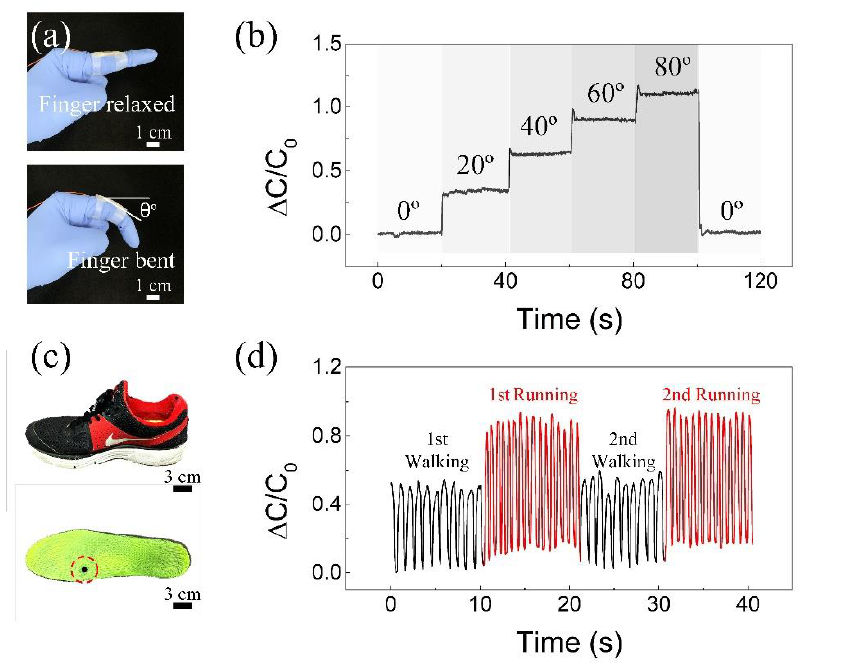
Figure 8. Demonstration of wearable devices with the flexible pressure sensor based on the PDMS / MS composite. For a wearable application, the sensor is placed onto the index finger and sole of the shoe. ( a ) The angle of the index finger is relaxed and bent at various bending stages. ( b ) Measurement results of relative capacitance values according to index finger’s angle. ( c ) Photos of the shoe and shoe insole with an attached sensor. ( d ) Capacitance response of the pressure sensor with repeated motions such as walking and running.